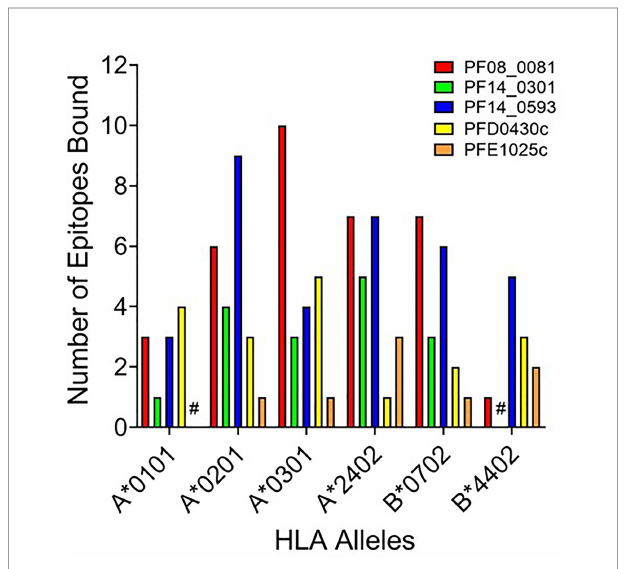
FIGURE 3 | HLA distribution of the number of epitopes for each protein with moderate to high af fi nity binding to the HLA supertypes. Shown are number of peptides with moderate to high binding af fi nity to HLA supertype allele for each peptide-allele combinations. Proteins that lacked peptides that bound to a speci fi c class I HLA allele are denoted by